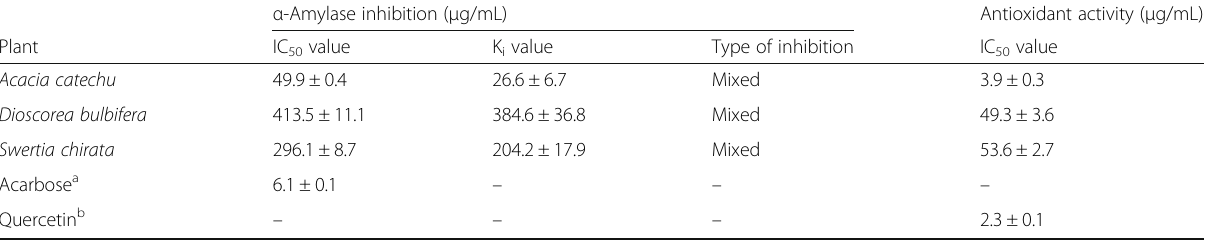
Table 2 α -Amylase inhibition (IC 50 ) and binding affinities of methanolic extracts (K i ) and their DPPH radical scavenging (antioxidant)